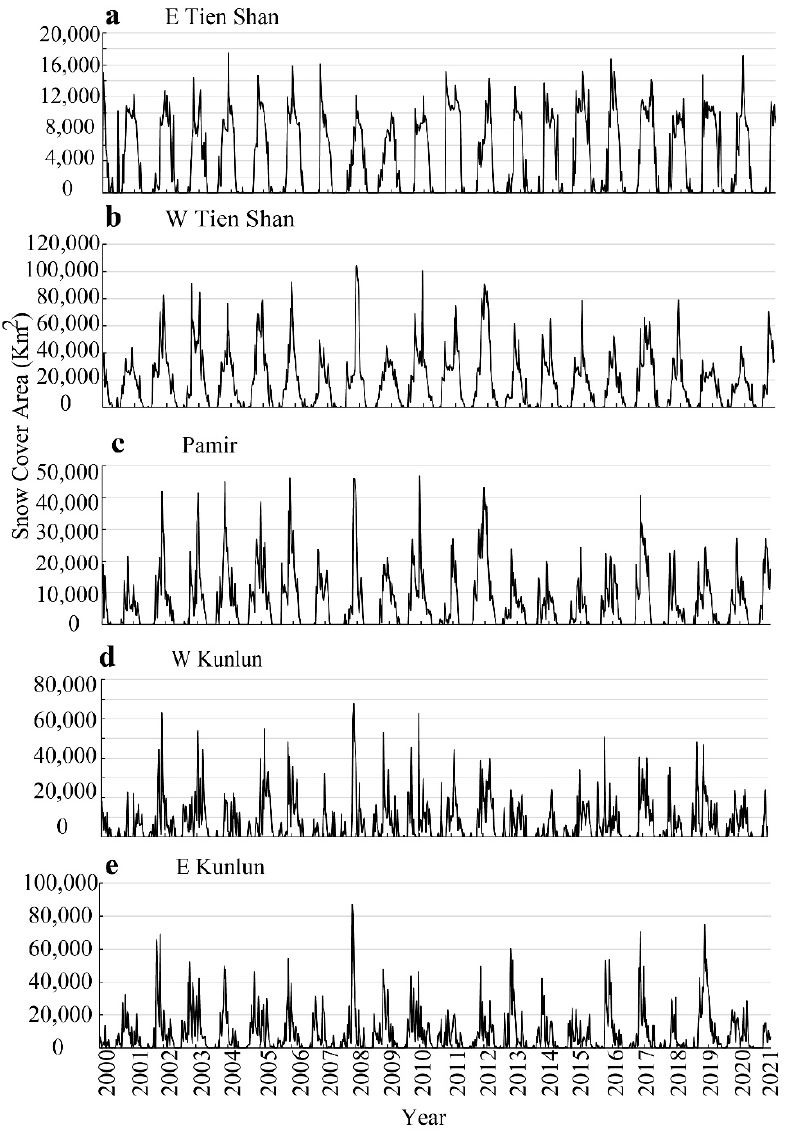
Figure 8. Eight-day interval snow cover area retrieved with MODIS data in the five subregions of the Tarim Basin: ( a ) E Tien Shan; ( b ) W Tien Shan; ( c ) Pamir; ( d ) W Kunlun; ( e ) E Kunlun.